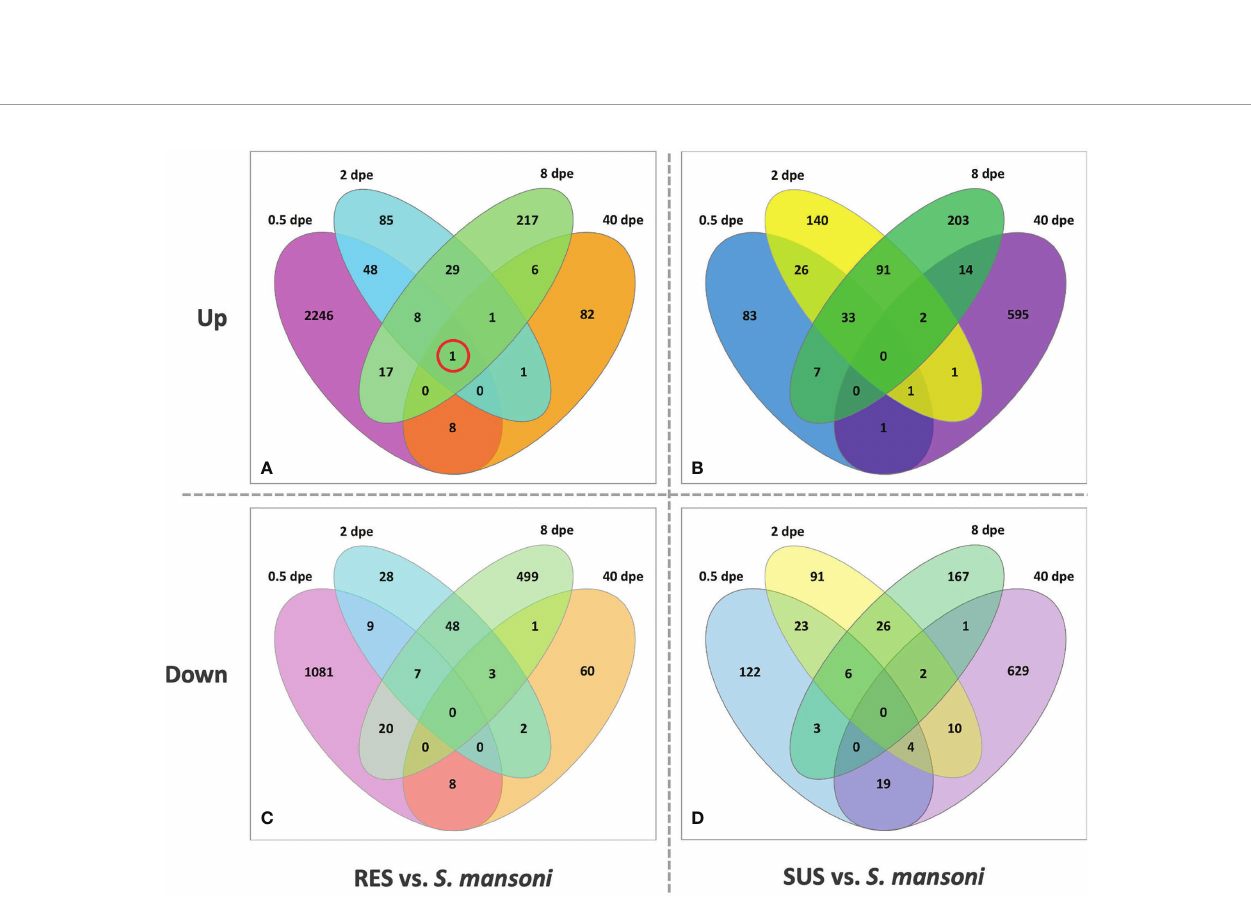
FIGURE 8 | Venn diagrams of RES (left panels) and SUS (right panels) snails exposed to S. mansoni for 0.5, 2, 8 and 40-days post-exposure (dpe). Numbers outside each oval refer to the speci fi c sampling time point; these sampling times are also indicated in Table S2 (Snail vs. Sm). The upper panels (A, C) refer to up- regulated genes and the bottom panels (B, D) to down-regulated genes. The single gene circled in red in panel (A) (FREP 4, Bg 152) was the only one found to be consistent in its expression at all four time